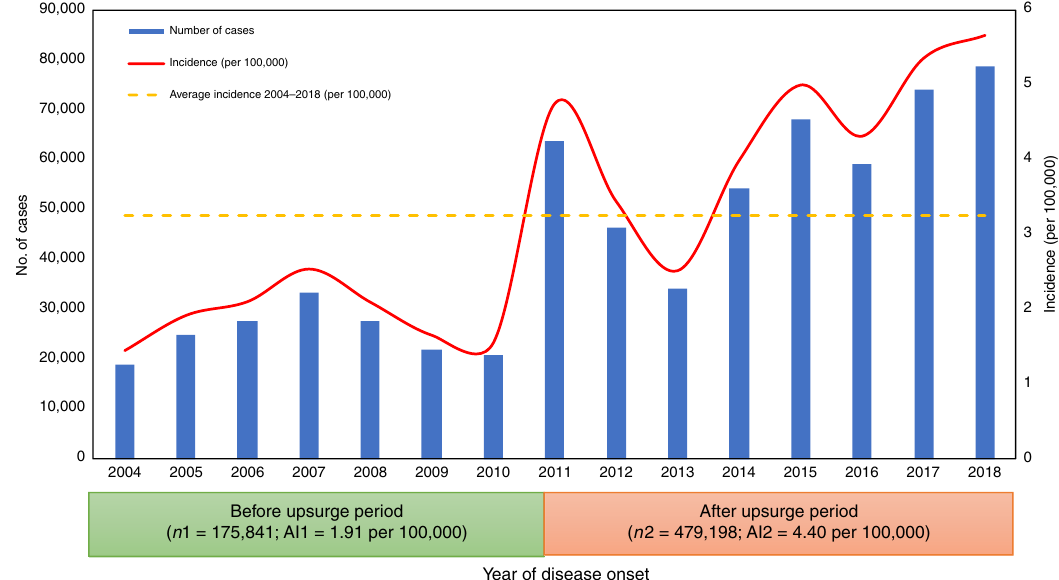
Fig. 1 Annual incidence rate of scarlet fever in all of China, 2004 – 2018. Blue bar: the number of scarlet fever noti fi cations by year; Red line: Annual scarlet fever incidence per 100,000 population by calendar year; Yellow line: the mean annual incidence for the period 2004 – 2018; We de fi ned the mean annual incidence as the cumulative number of annual scarlet fever cases (2004 – 2018) divided by the general population size (2004 – 2018); AI1 = average annual incidence 2004 – 2010 (per 100,000). We de fi ned AI1 as the cumulative number of annual scarlet fever cases (2004 – 2010) divided by the general population size (2004 – 2010); AI2 = average annual incidence 2011 – 2018 (per 100,000). We de fi ned AI2 as the cumulative number of annual scarlet fever cases (2011 – 2018) divided by the general population size (2011 – 2018). The fi gure consists of 655,039 scarlet fever cases between January 1, 2004 and December 31, 2018. Scarlet fever started to surge in 2011 and peaked in 2018 (5.67 per 100,000 population). After the upsurge in 2011, the annual incidence of scarlet fever remained higher than average level except for in 2013. Source data are provided as a Source Data fi le.